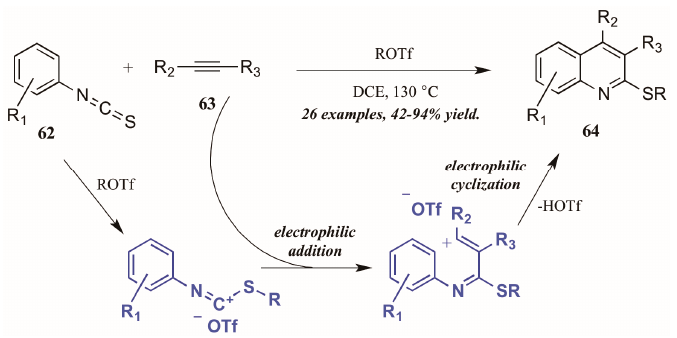
Figure 29. Alkyltriflate-mediated electrophilic cyclization of isothiocyanates with alkynes.